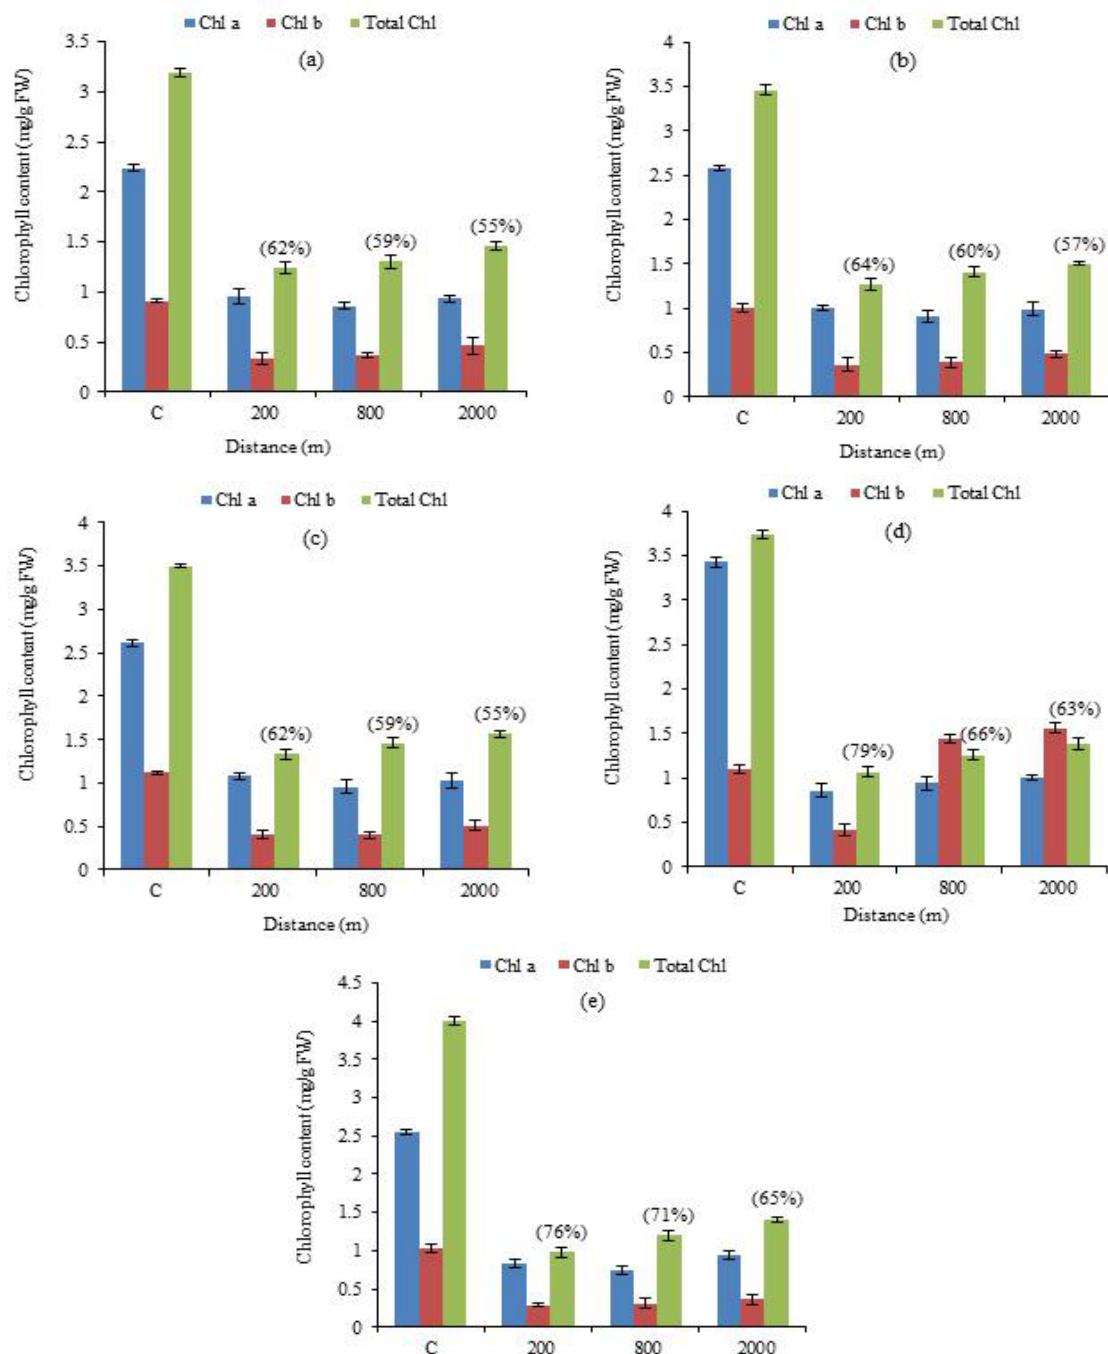
Fig. 2: Chlorophyll content ( a, b and total) (mg g -1 FW) and percentage decrease over control in study area’s Triticum aestivum L in the age of 20 (a), 40 (b), 60 (c), 80 (d) and 100 days